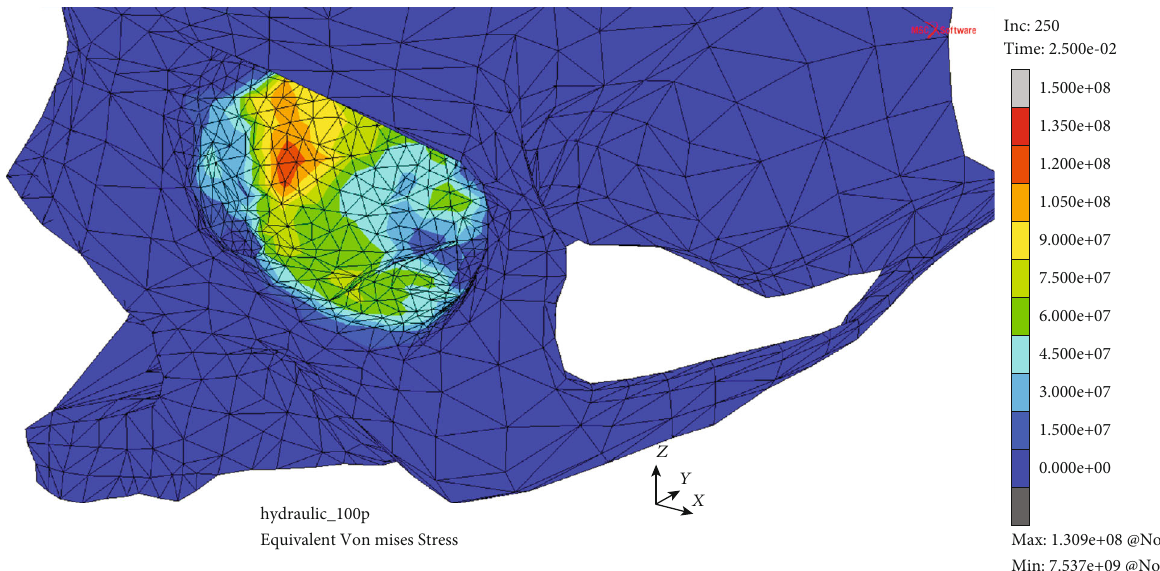
Figure 6: H-M-H stress distribution (Pa) without the deformation within the analyzed thin shell skull part during time t = 25 : 0ms